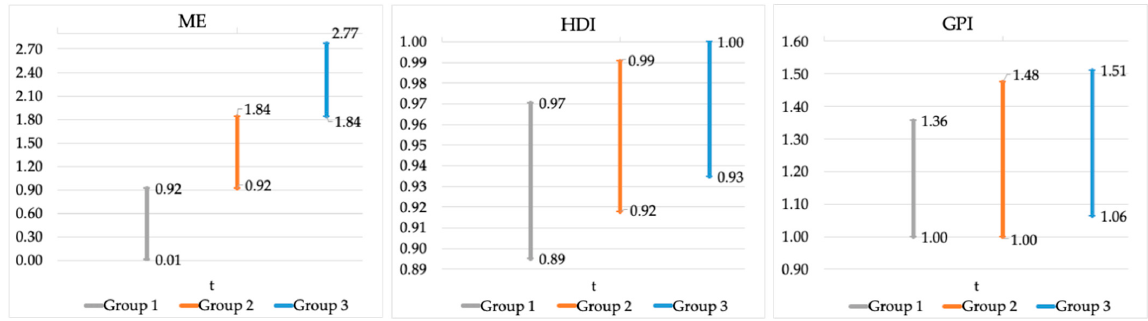
Figure 6. Ranges of the objective functions by groups of the ε -Pareto front, defined by MEs.